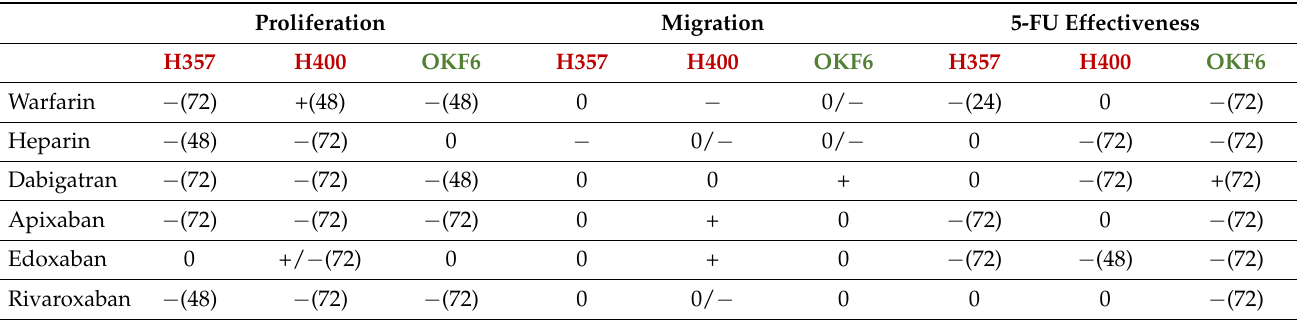
Table 1. Summary of the main in vitro